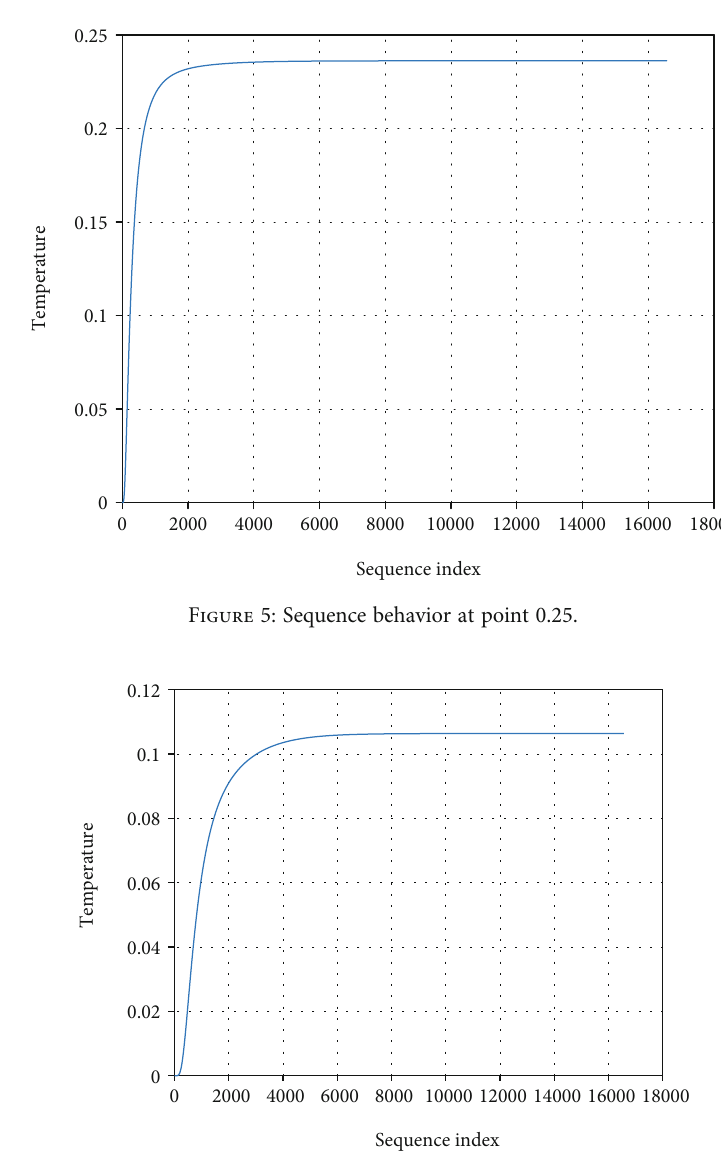
Figure 6: Sequence behavior at point